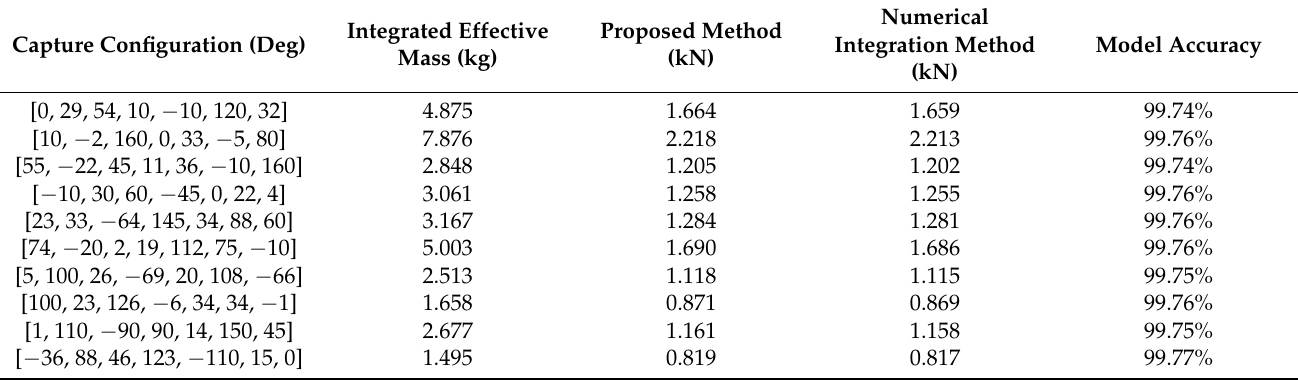
Table 6. Accuracy of maximum-contact-force model for 7-DOF space